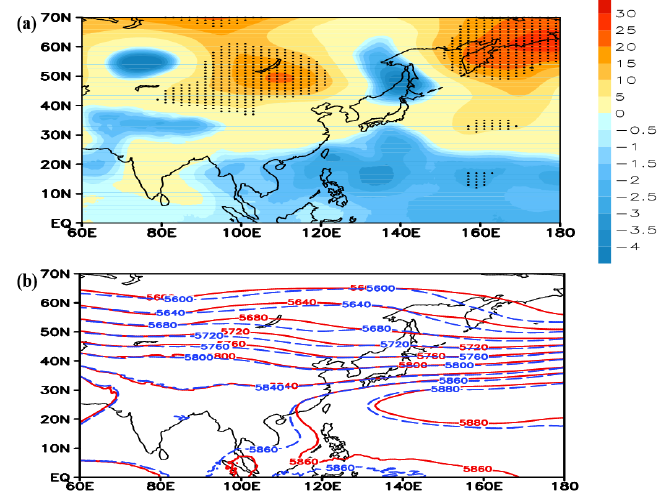
Figure 6. ( a ) Composite difference (unit: gpm) in summer 500-hPa geopotential heights between the periods 1990–1999 and 2000–2009, in which black dots denote the anomalies significant at the 90% confidence level. ( b ) Summer geopotential heights (unit: gpm) averaged for the periods 1990–1999 (blue contours) and 2000–2009 (red contours).